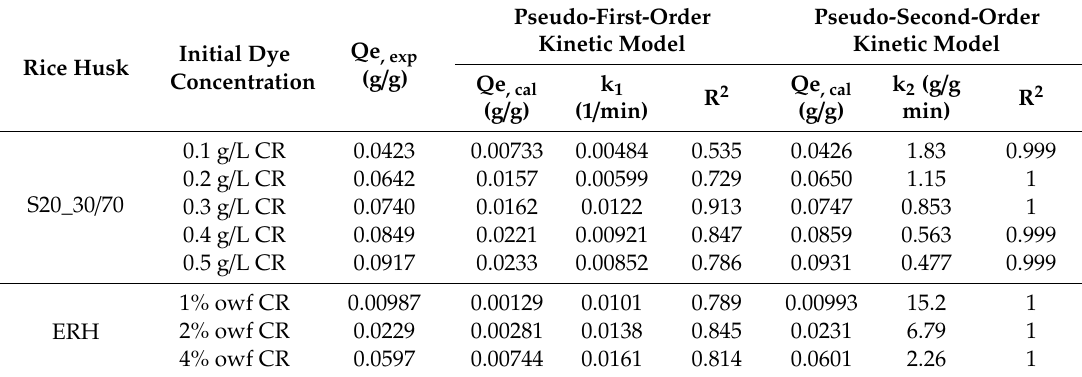
Table 7. Kinetic parameters for adsorption of Congo red (CR) onto S20_70 / 30 and ERH rice husks.